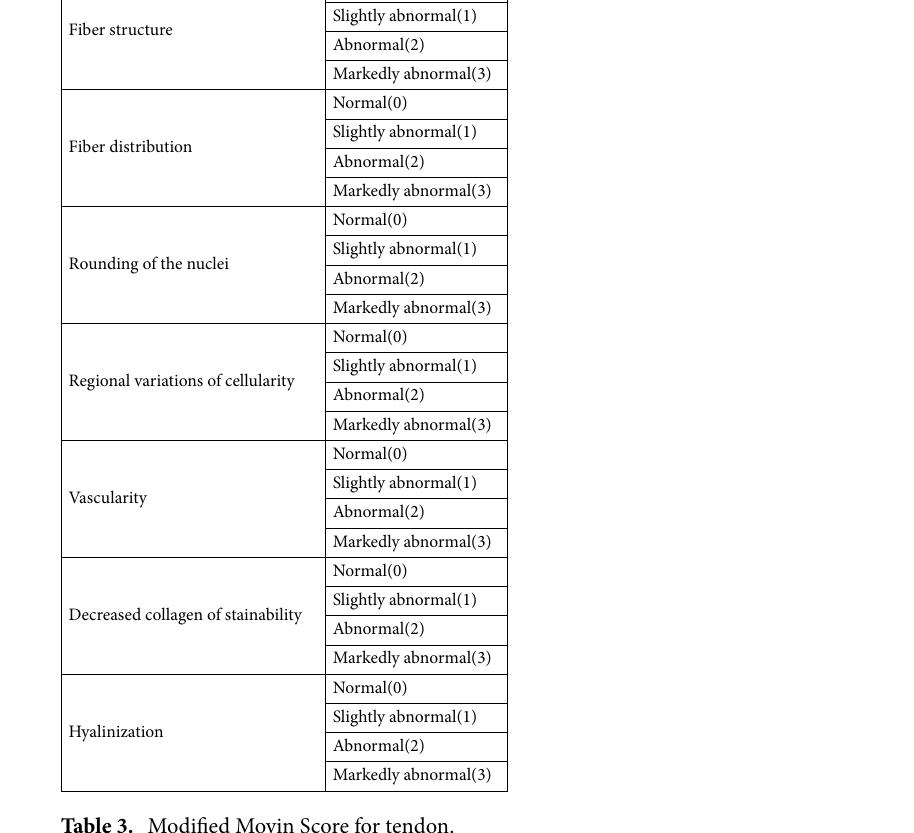
Table 3. Modified Movin Score for